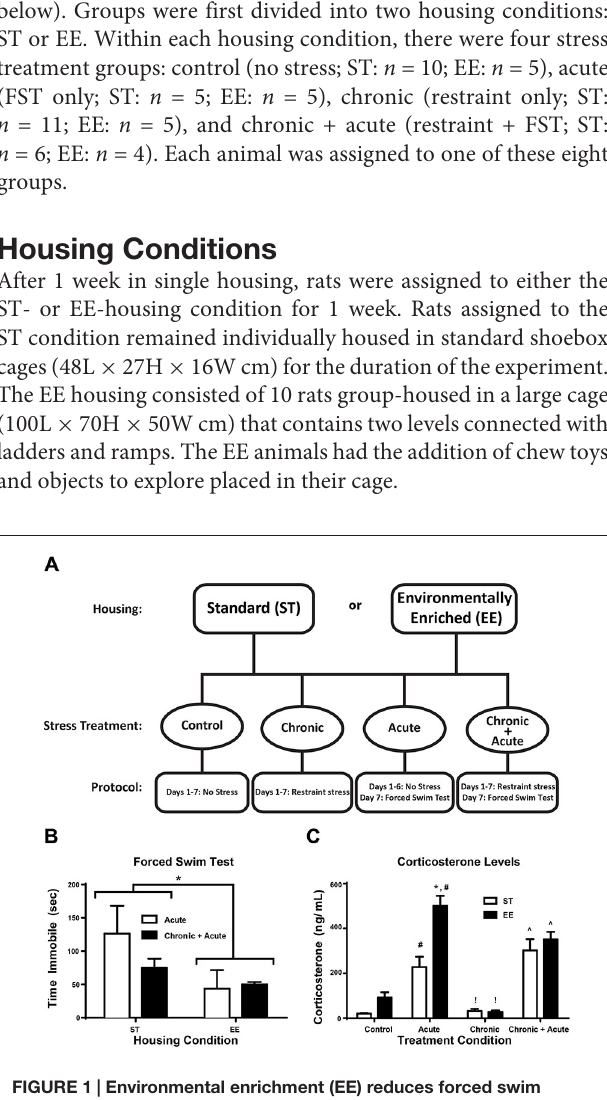
FIGURE 1 | Environmental enrichment (EE) reduces forced swim immobility time and increases corticosterone (CORT) levels after acute stress. (A) Experimental design is illustrated across days for the two housing conditions and for the four stress treatments. (B) Time immobile during the FST for acute and chronic + acute groups show an overall significant effect of housing condition where EE-housed animals spent significantly less time immobile compared to standard (ST)-housed animals ( ∗ p < 0.05). (C) There was a significant increase in CORT levels after acute stress for both